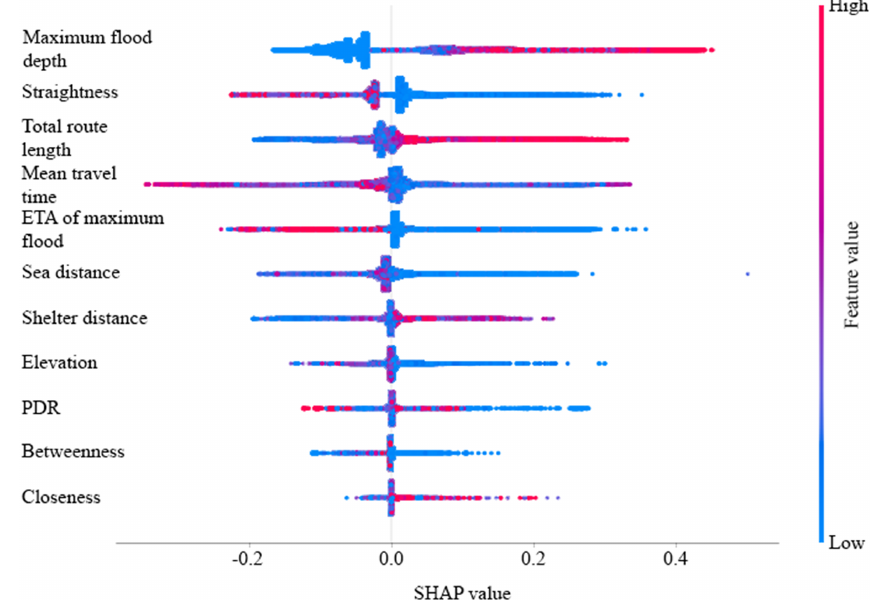
Figure 6. SHAP values of the independent variables.